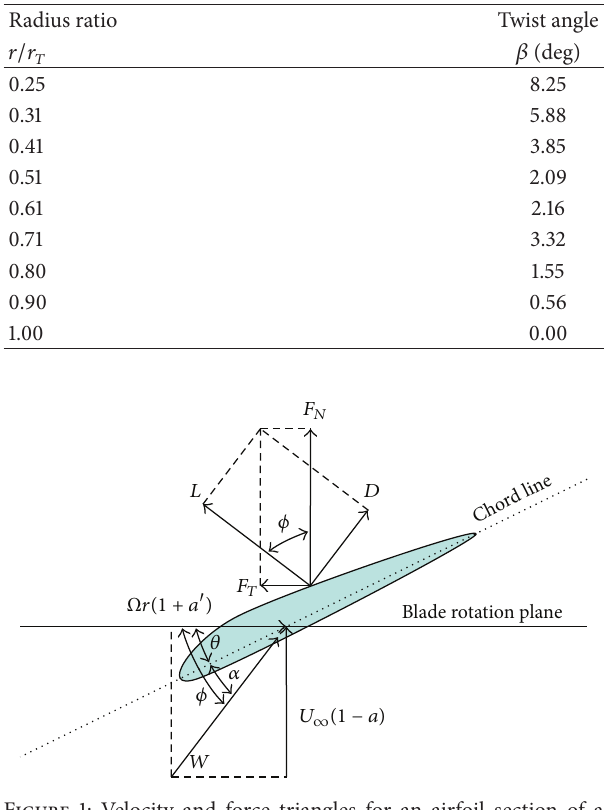
Table 1: Twist angle distribution of the manufactured turbine blades.